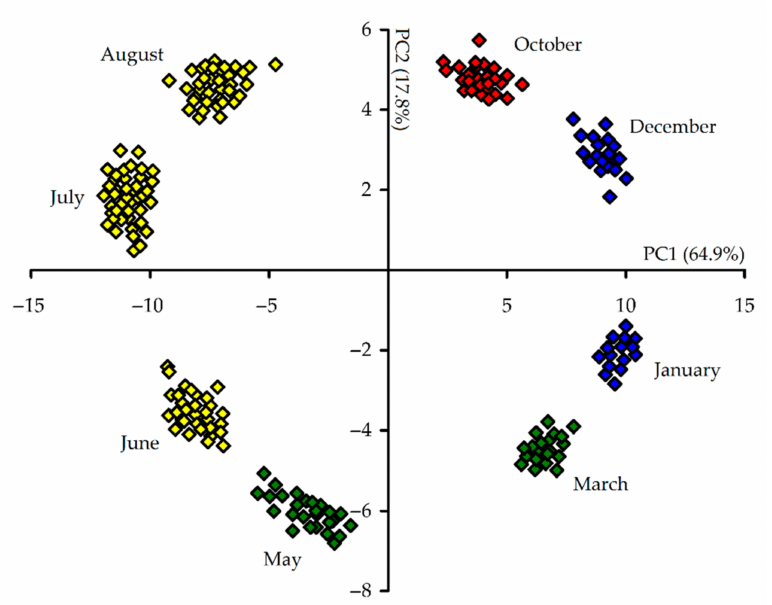
Figure 9. Principal component analysis (PCA) for the content of 171 compounds in 215 samples of R. adamsii leaves collected during various months of the